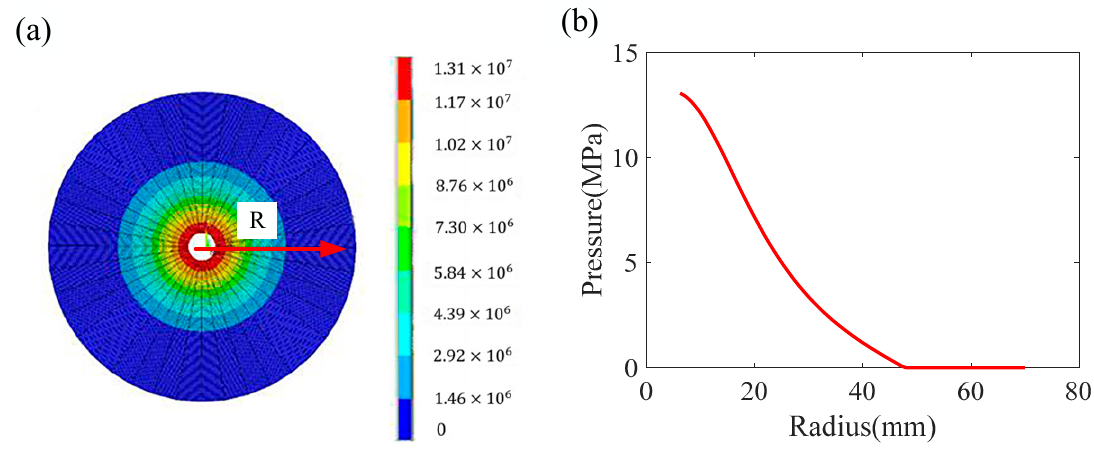
Figure 2. Contact results: ( a ) contact pressure, ( b ) pressure distribution.